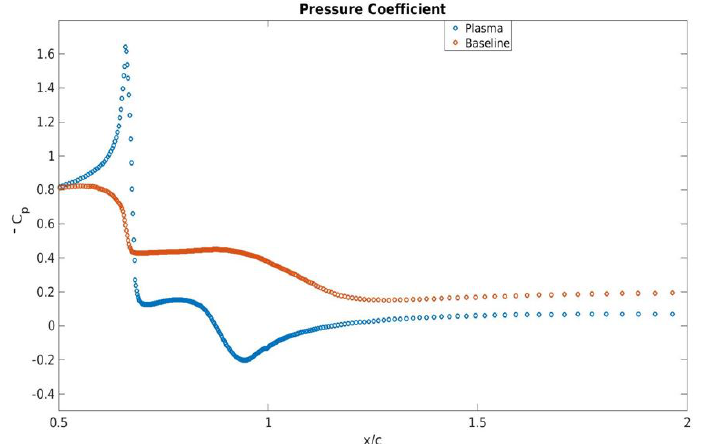
Figure 16. Coefficient of pressure comparison between the baseline and plasma